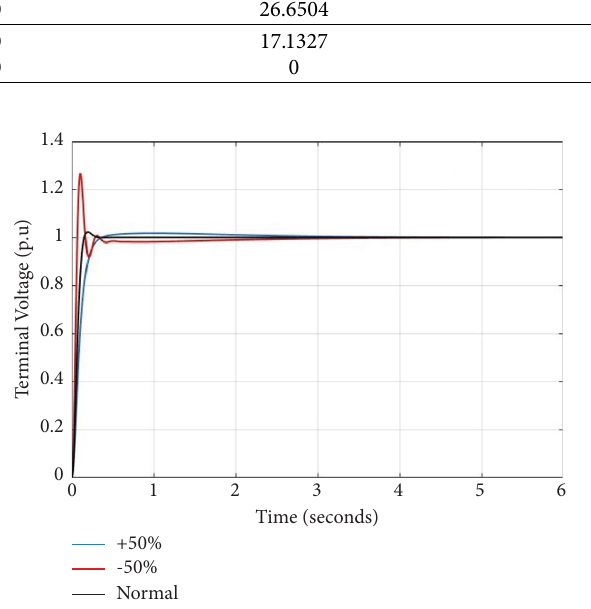
Figure 16: Response of terminal voltage using MESOBC for normal and ± 50% uncertainties in T